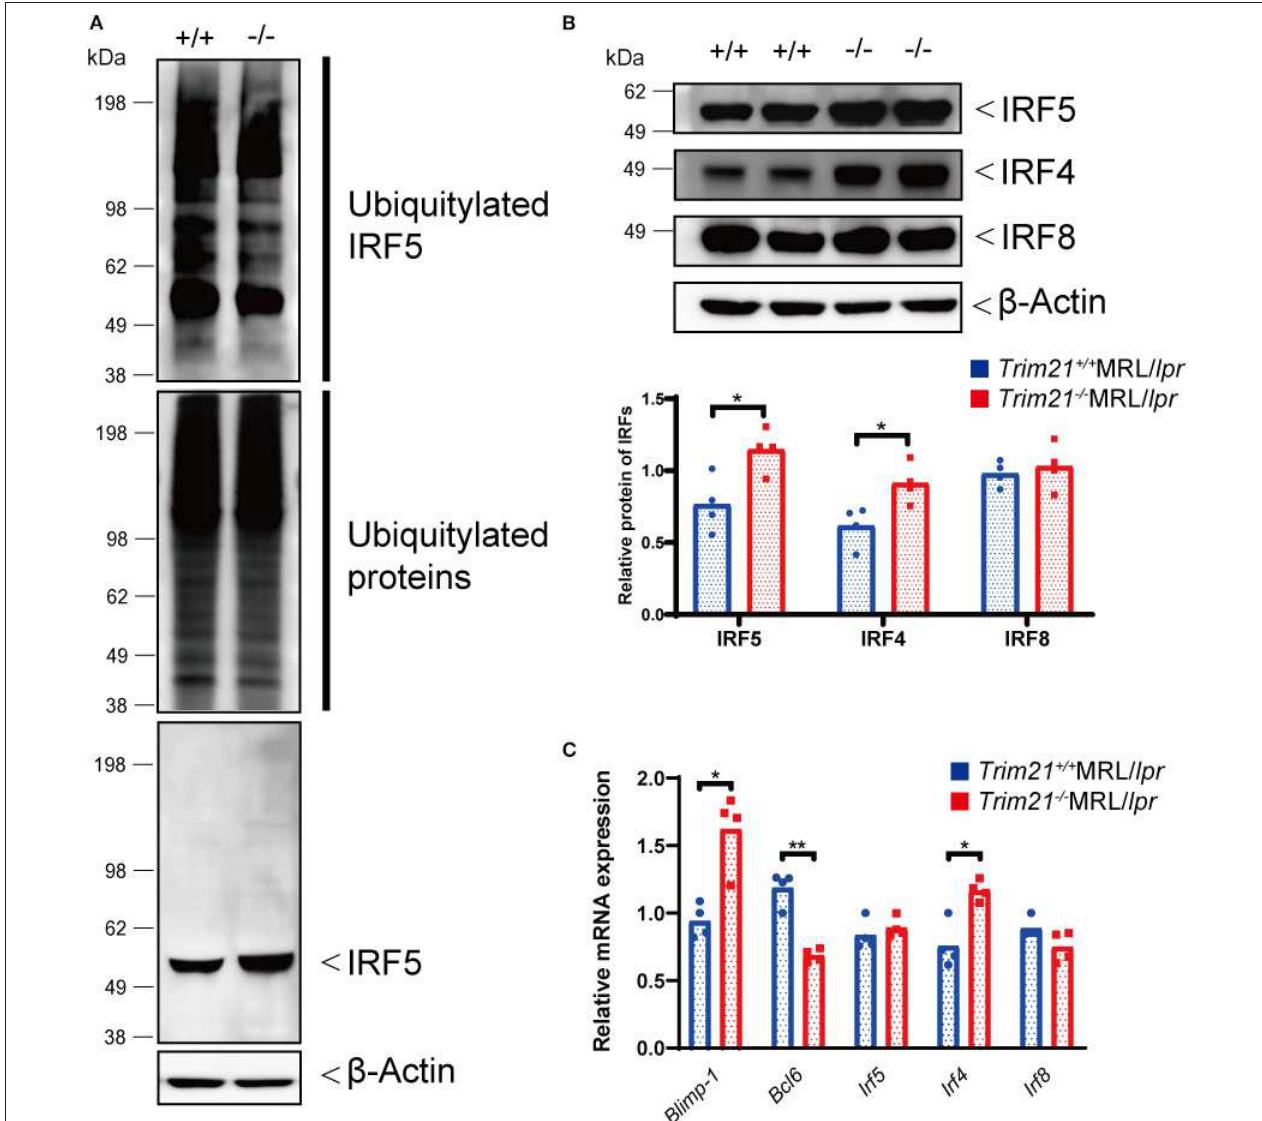
FIGURE 8 | TRIM21 deficiency causes overexpression of IRF5 due to decreased ubiquitylation. (A) Extracts from resting B cells from Trim21 + / + and Trim21 − / − MRL/ lpr mice, which were stimulated with anti-IgM Ab and TLR3 ligand for 72h, were immunoprecipitated with anti-IRF5 Ab and blotted with anti-ubiquitin Ab. Ubiquitylated IRF5 protein in the total cell lysate is decreased in the total extracts from Trim21 − / − MRL/ lpr mice as compared with Trim21 + / + MRL/ lpr mice ( top panel ). The amount of total ubiquitylated proteins is not different in two genotypes ( the second panel ). The amount of unubiquitylated IRF5 protein was higher in cells from Trim21 − / − MRL/ lpr mice as compared with Trim21 + / + MRL/ lpr mice ( the third panel ). β -Actin was used as a loading control ( the lowest panel ). (B) Western blot analysis shows that the expression level of IRF5, IRF4, and IRF8 protein in resting B cells at 72h after stimulation with anti-IgM Ab and TLR3 ligand is higher in Trim21 − / − MRL/ lpr mice as compared to Trim21 + / + MRL/ lpr mice ( n = 4 in each group). (C) mRNA expression levels of Blimp-1, Bcl6 , Irf5 , Irf4 , and Irf8 in resting B cells at 72h after stimulation with anti-IgM Ab and TLR3 ligand ( n = 4 in each group) in qPCR. Statistically significant (* p < 0.05 and ** p < 0.01) data by Student’s t -test,